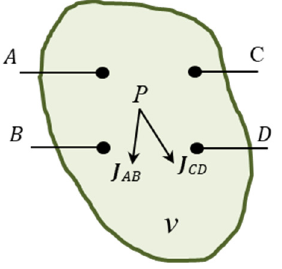
Fig.1: Schematic of current density vectors at point P for two pairs of electrodes AB and CD placed on the surface of a volume